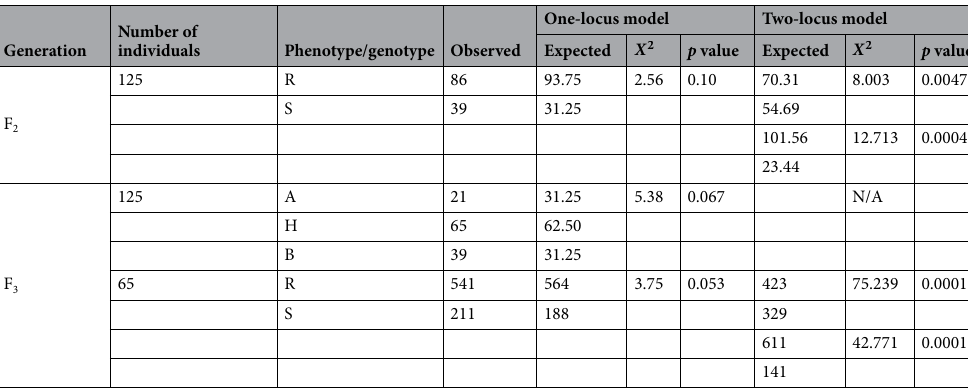
2 Table 1. Chi-square ( X ) goodness-of-fit test for L. trifolii resistance using one-locus and two-locus models in romaine lettuce. R, resistant; S, susceptible; A, homozygous resistant; H, heterozygous; B, homozygous susceptible. One-locus dominant model was tested for both genotypic (1:2:1) and phenotypic (3:1) ratios. † Complementary gene action (9:7). ‡ Recessive suppressor